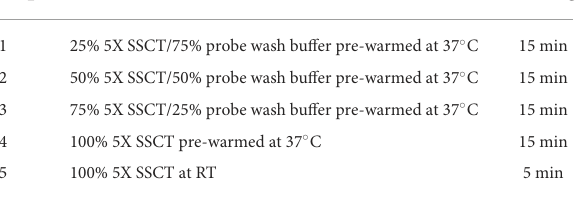
TABLE 1 Probe wash steps for the HCRv3